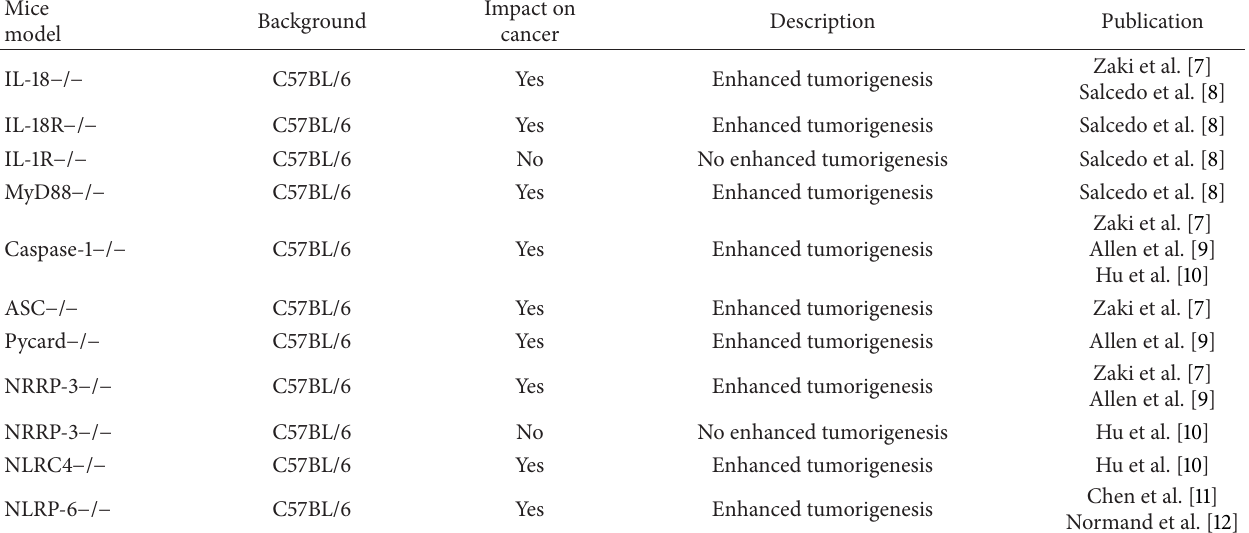
Table 1: Studies evaluating the role of the inflammasome in colitis-associated cancer using the AOM/DSS